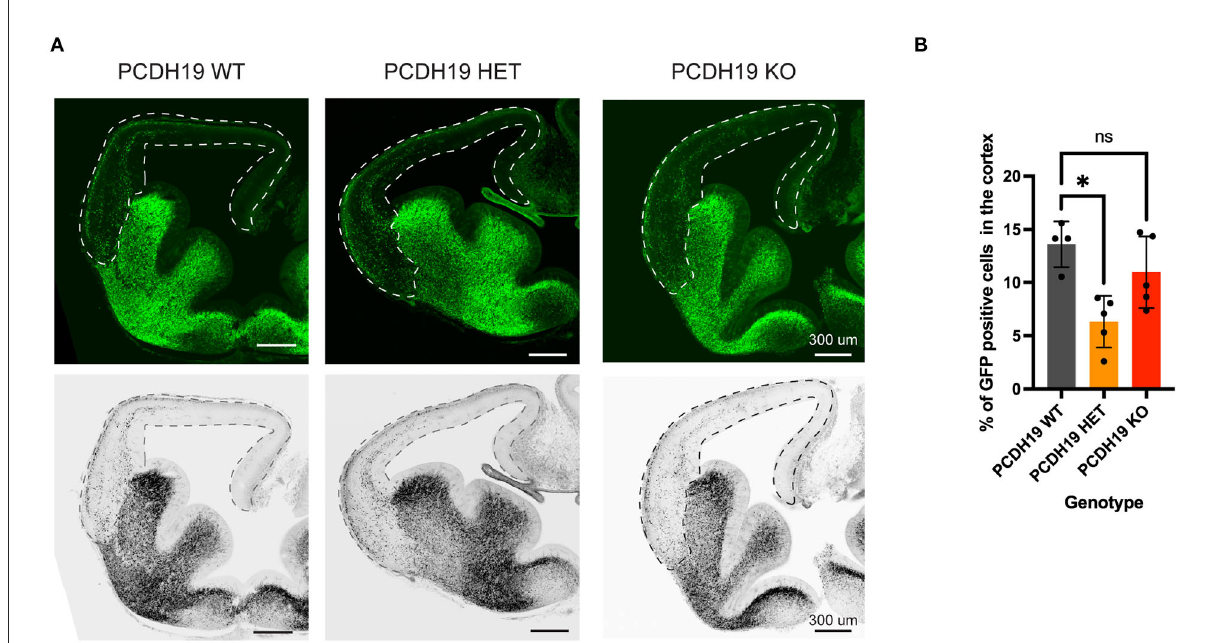
FIGURE7 Cortical interneuron migration upon loss of PCDH19 in vivo . (A) Representative brain slices for the PCDH19 WT mouse, the PCDH19 HET mouse, and the PCDH19 KO mouse; the dotted line represents the area that was measured. (B) Quantification of GFP positive cells in the measured area shows average of GFP-positive cells percentage in the cortex per mouse genotype. Less migration to the cortex could be detected in the PCDH19 HET mouse compared to the control PCDH19 WT (* p = 0.0135), the Kruskal–Wallis test, and the Dunn’s post hoc